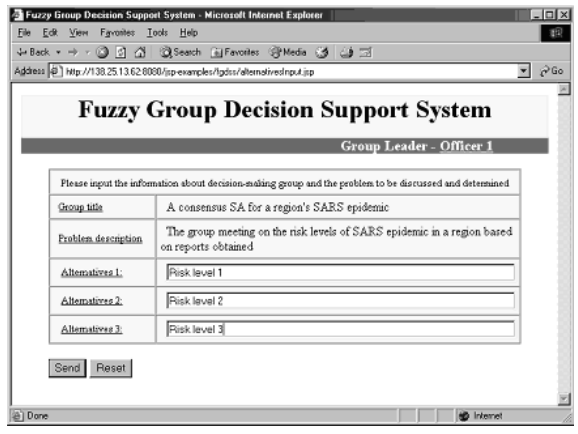
Fig. 2. Three SA alternatives proposed by team members